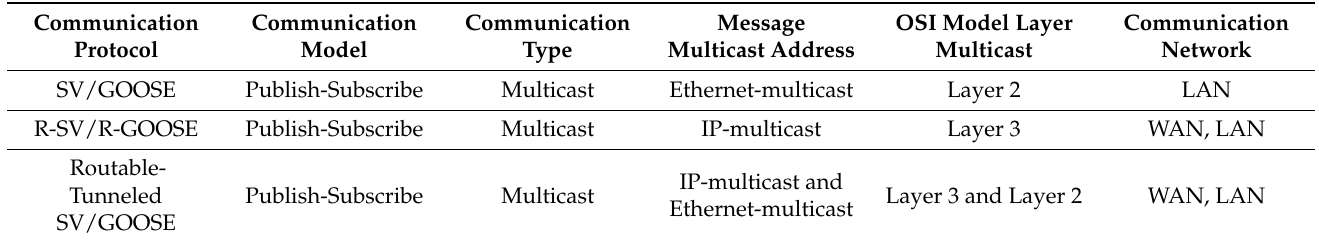
Table 1. Comparison of IEC61850 multicast messages.